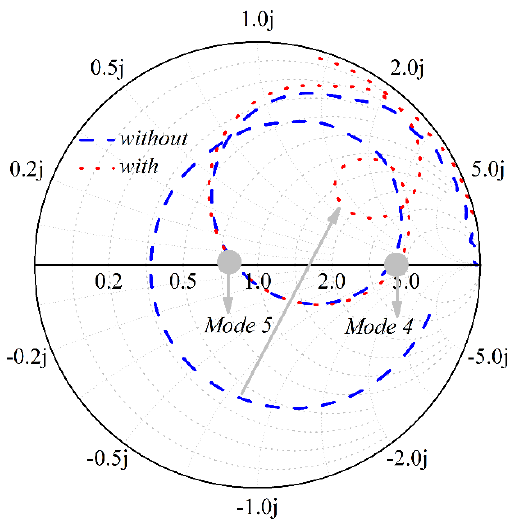
Figure 7. Smith chart with and without the shorting pin ② for the proposed T-shaped antenna.